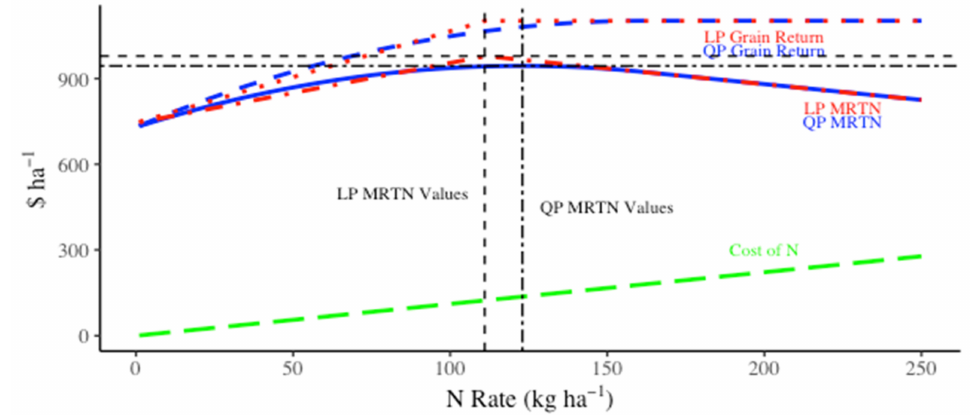
Figure 3. A graphical representation of the maximum return to N (MRTN) approach. The dotted red line and dashed blue line represent a typical linear plateau (LP) and quadratic plateau (QP) grain yield, respectively. The dot-dash red line and solid blue line represent the LP and QP MRTN. The MRTN